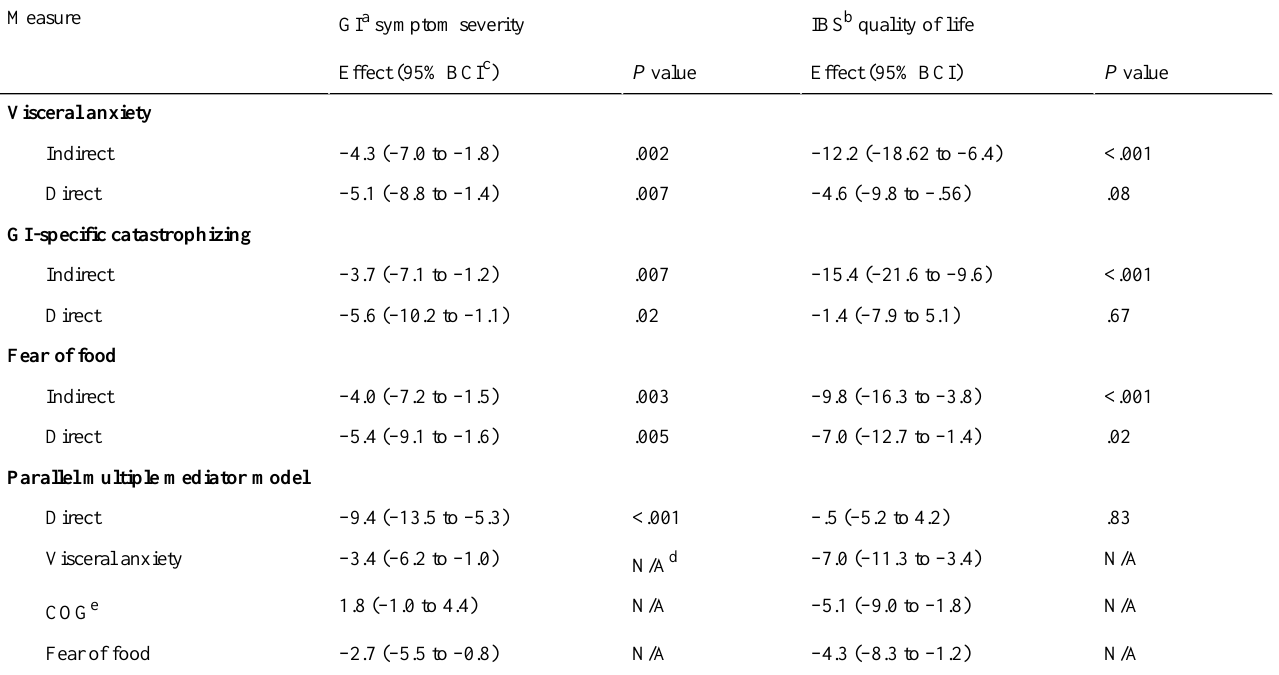
Table 8. Direct and indirect mediation results.